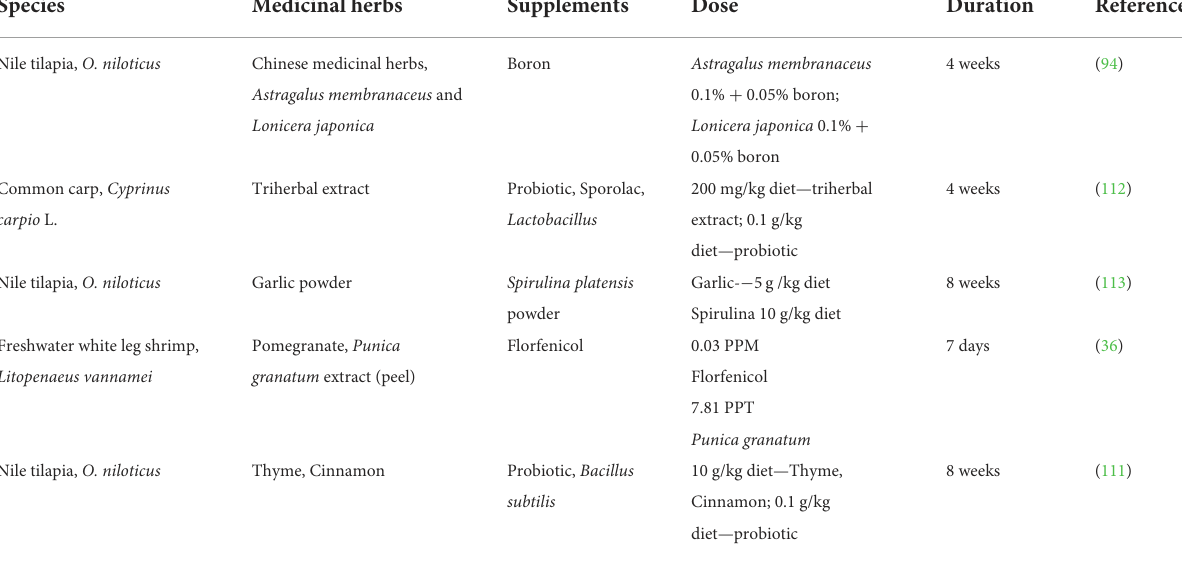
TABLE 4 Medicinal herbs and antimicrobial/therapeutic agents reduce the impacts of A. hydrophila on aquatic animals.